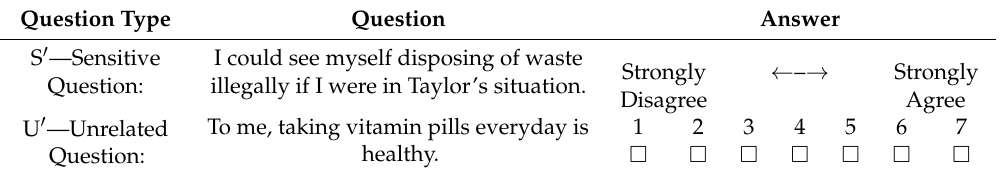
Table 4. Sample questions for assessing intention of illegal waste disposal using the